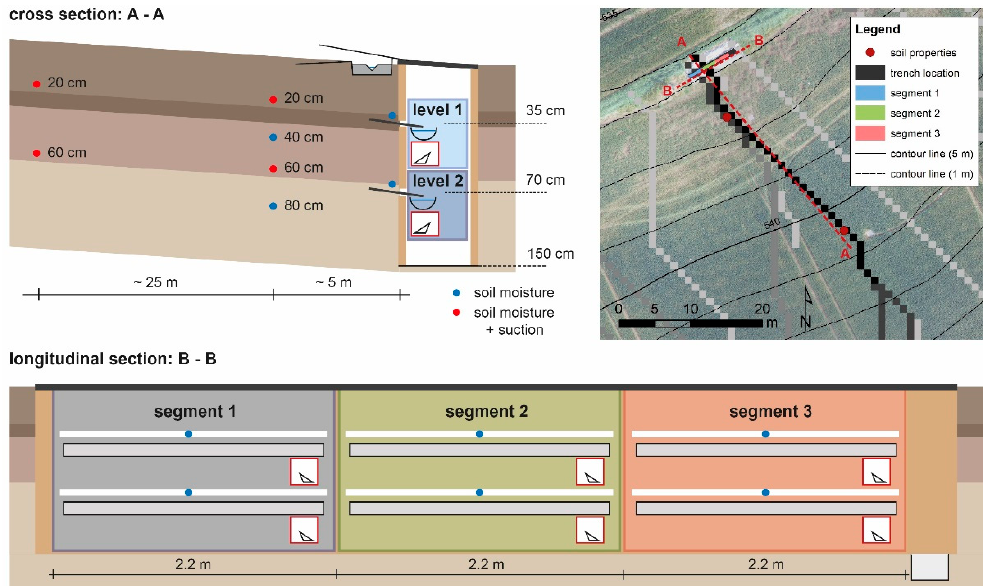
Figure 2. Cross section and longitudinal section of the trench and the slope with derived surface pathways and soil measurement plots. The subsurface flow was measured in six sections and was subdivided into two levels and three segments.